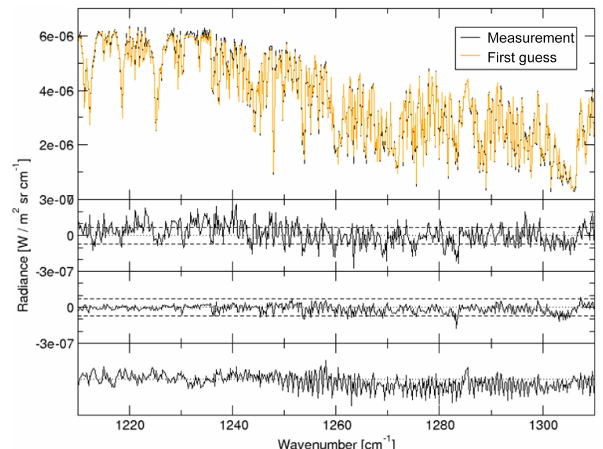
Figure 8. Comparison of GOSAT-TIR measurement with a forward model calculation based on methane profiles as measured during the HIPPO campaigns. The upper panel shows a single GOSAT measurement (black) and the forward calculation based on the co- located HIPPO measurement (orange), and in the second panel the residual is shown. The third panel depicts the average residual of all 300 GOSAT-HIPPO pairs used to centre all residuals in the principal component analysis. In the bottom panel the first principal compo- nent of this analysis is